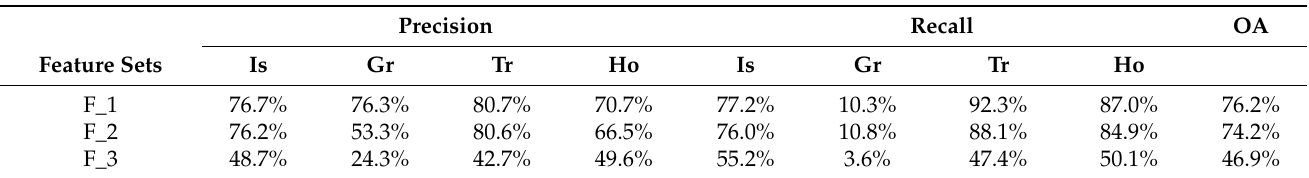
Table 2. Classification results of each type of objects with different feature subsets from different data sources.